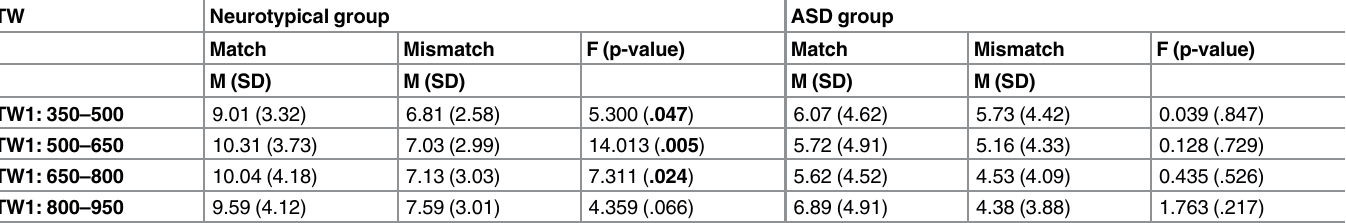
Table 3. Mean amplitude and standard deviations of the ERP waveforms in the two conditions (Match and Mismatch) time-locked to the auditory word for the vertex array at four time windows for Neurotypical and ASD groups. TW Neurotypical group ASD group Match Mismatch F (p-value) Match Mismatch F